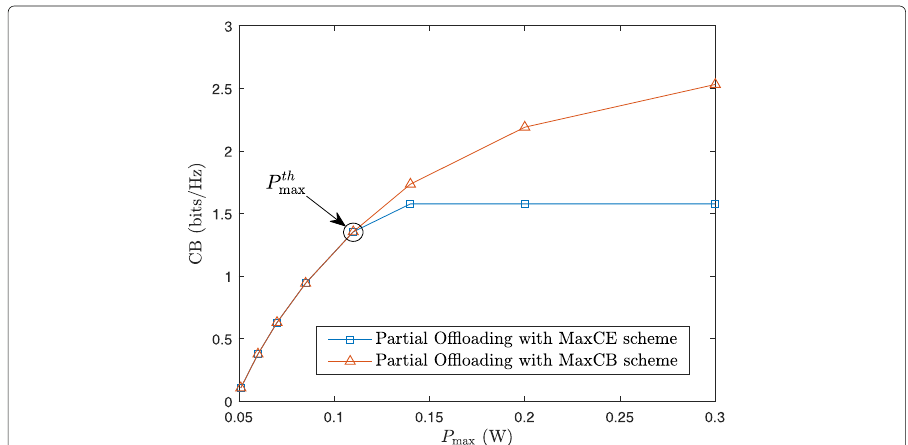
Fig. 4 Comparison of CBs under partial offloading mode with CE maximization and CB maximization